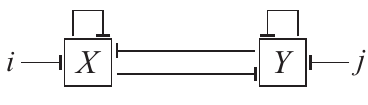
Figure 2. Biological scheme of gene regulatory network presenting the toggle switch circuit, where X and Y present proteins observed and i and j present external influences on the behaviour of the circuit. Connections among different parts of the circuit present their mutual